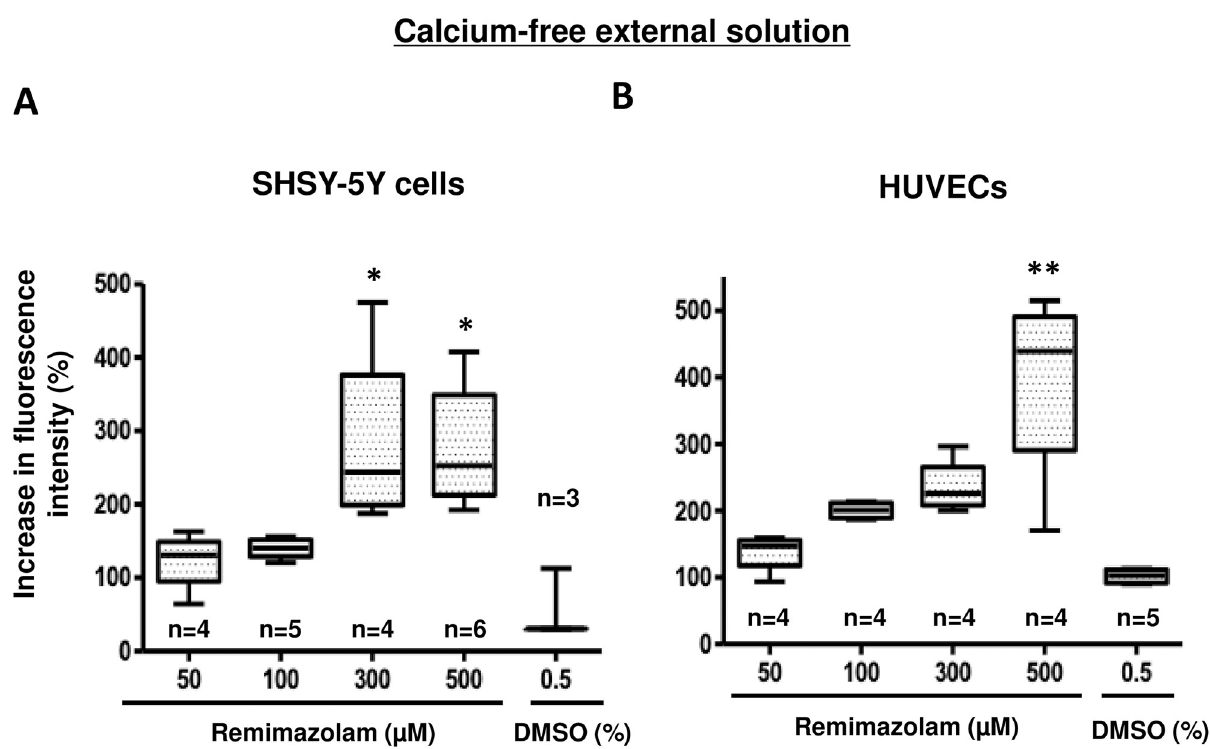
Fig 3. Characterization of remimazolam-induced intracellular calcium elevation in the absence of extracellular calcium. After eliminating calcium from the extracellular buffer, remimazolam-induced elevation of intracellular calcium was observed at concentrations between 0 and 500 μ M in SHSY- 5Y cells and HUVECs. (A) Remimazolam (300 μ M)-induced elevation of intracellular calcium was not influenced by the elimination of extracellular calcium in SHSY-5Y cells (n = 3–7, � p < 0.05, compared to control, one-way ANOVA followed by Dunnett’s post-test). The same concentration of DMSO corresponding to 500 μ M of remimazolam was administered as a control. The horizontal line in each box indicates the median, the box shows the interquartile range (IQR), and the whiskers represent 1.5 × IQR. (B) Remimazolam (300 μ M)-induced elevation of intracellular calcium was not influenced by the elimination of extracellular calcium in HUVECs (n = 3–7, � p < 0.05, compared to control, one-way ANOVA followed by Dunnett’s post-test). The same concentration of DMSO corresponding to 500 μ M of remimazolam was administered as a control. The horizontal line in each box indicates the median, the box shows the interquartile range (IQR), and the whiskers represent 1.5 ×